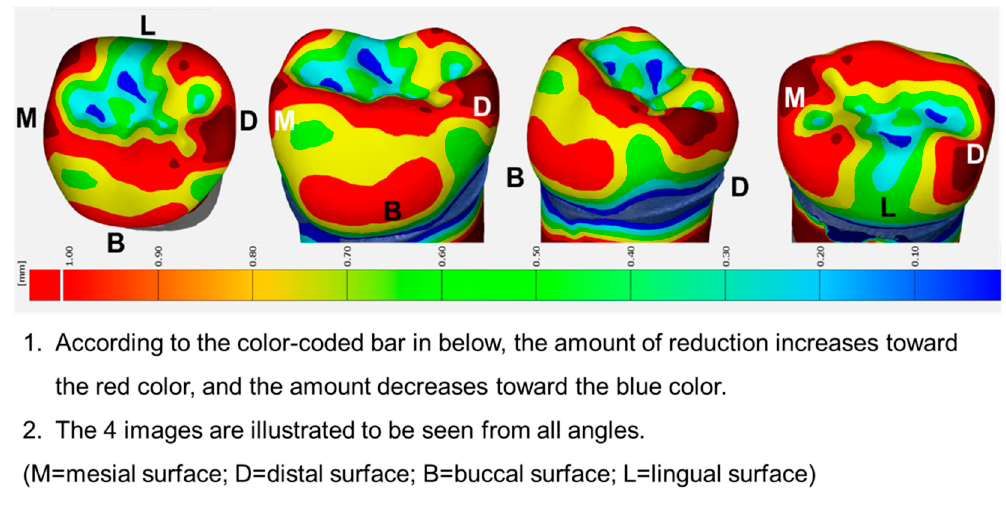
Figure 5. 3D visualization of the tooth preparation guide of the left mandibular primary second molar. The required amounts of tooth reduction are provided by a color-coded map. A detailed explanation of the figure was provided to the participants in Korean.